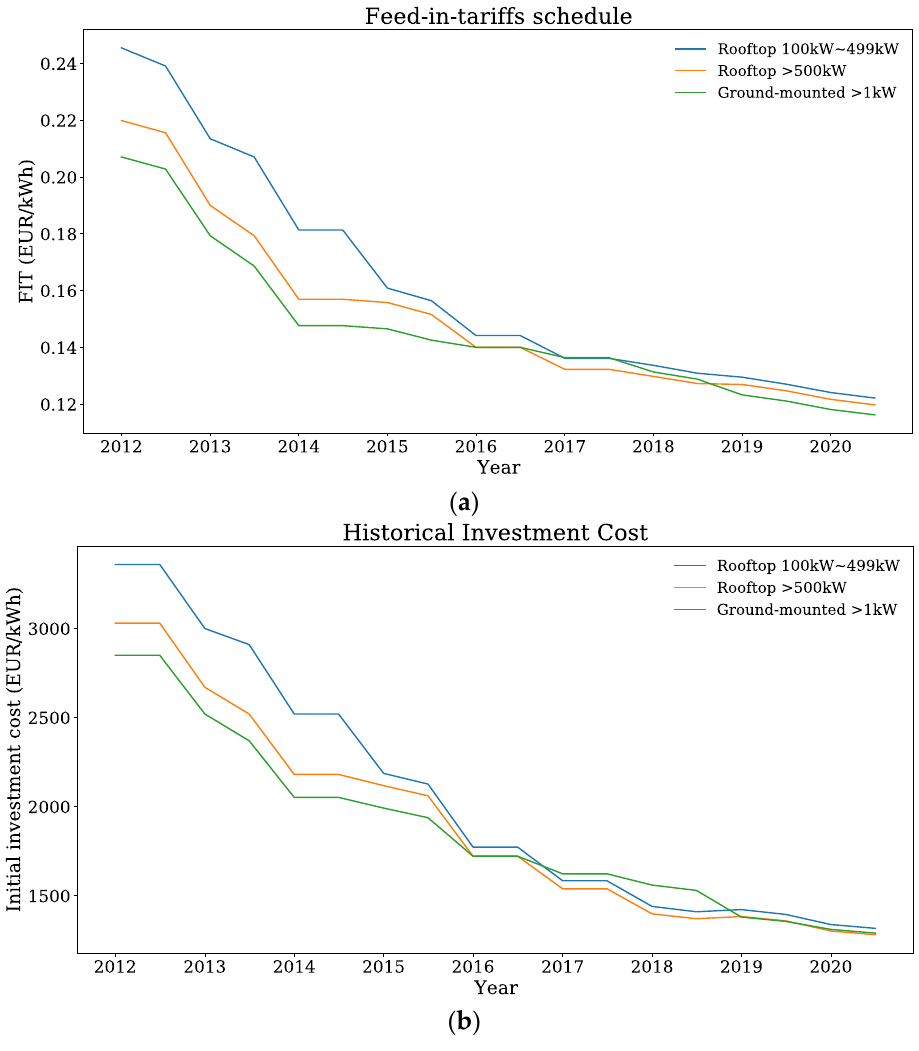
Figure 3. ( a ) FIT schedule from 2012 to 2020 ( b ) Investment cost from 2012 to 2020 Source: [15], self-elaboration.